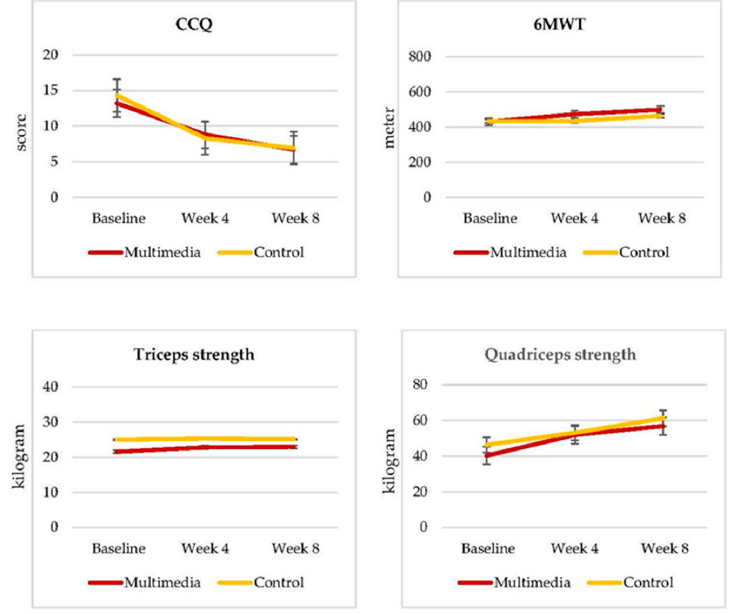
Figure 2. The trend results of clinical COPD questionnaire, 6 min walk test, and muscle strength of upper and lower extremities before and after the home-based pulmonary rehabilitation program between the multimedia and control groups.